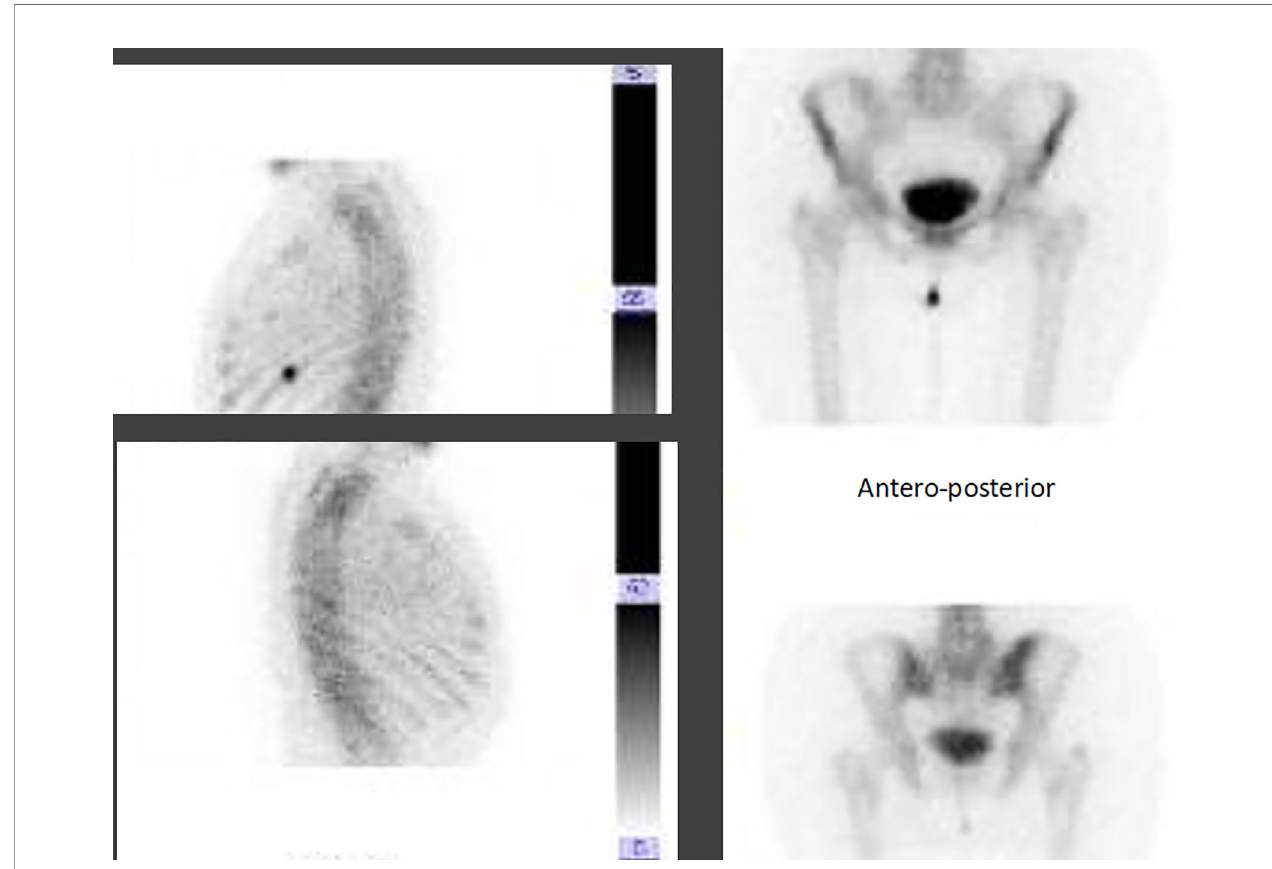
FIGURE 5 | Bone scan evaluation, before and after treatment with ribociclib and